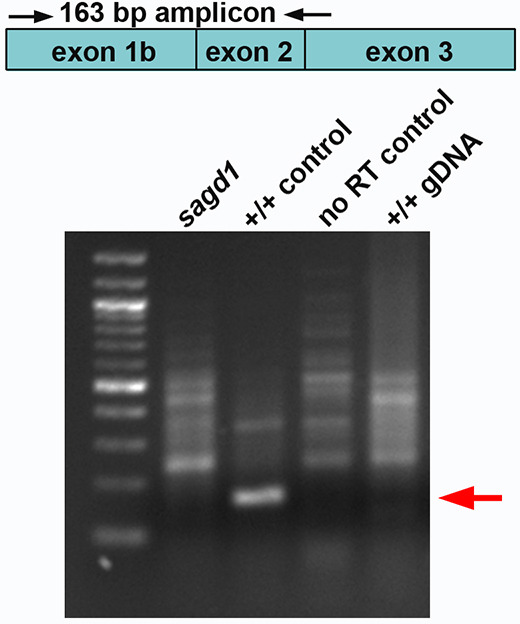
RT-PCR identification of pgk1-alt.RT-PCR was conducted on mRNA harvested at 24 hpf using primers binding near the 5’ end of exon1b and at the exon2/3 junction. A 163 bp amplicon (red arrow) was obtained from wild-type embryos but not sagd1- / - mutants. As controls, reverse transcriptase was excluded from wild-type mRNA samples (no RT control), or genomic DNA was used as template (+/+ gDNA).